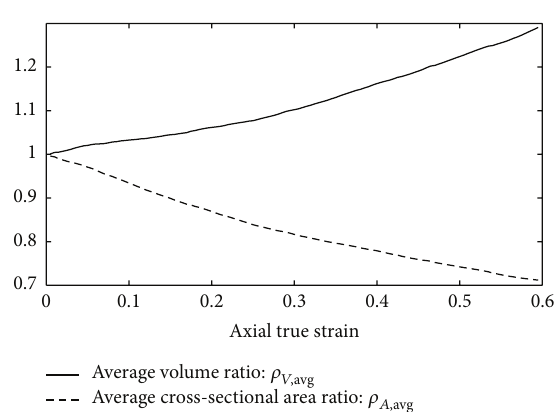
Figure 10: Strain rate variation during quasi-static and dynamic